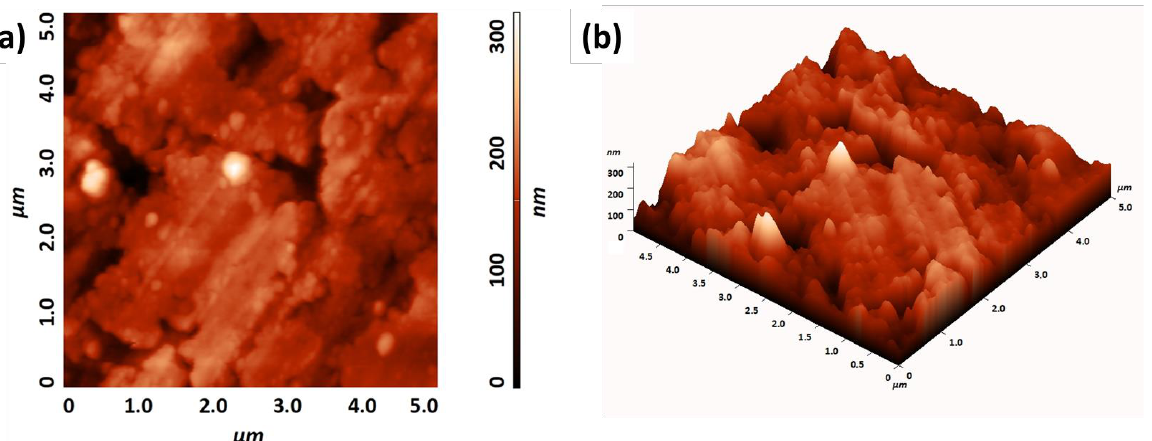
Figure 5. ( a ) Two-dimensional and ( b ) 3D AFM topographical images (RMS roughness of 29.4 nm on 2.5 × 2.5 µm area) of the BaCeO 3 film grown on the MgO substrate at a deposition temperature of 950